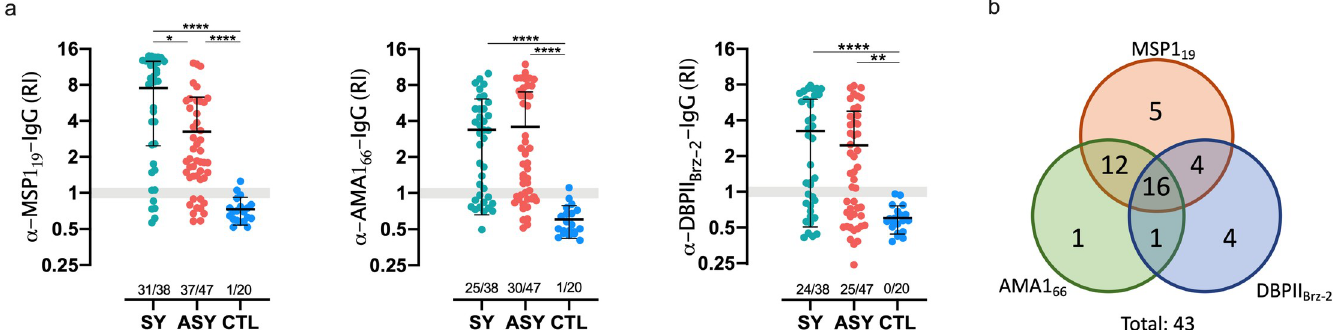
Fig 5. Asymptomatic individuals have higher levels of IgG against P . vivax antigens compared to healthy controls. a) Reactivity index for each individual by group for the three antigens. Each dot represents individual values of each analyte by group. Gray background represents the cut-off threshold. Data above the background is positive, and bellow, negative. Data upon the gray line is considered inconclusive. Y-axis is Log2 transformed to better show the distribution of negative individuals. Only significant differences were shown. �� p < 0.01. ���� p < 0.0001. Dunn’s test. b) Venn’s Diagram depicting the distribution of IgG positive ASY for the three antigens. RI–reactivity index. SY–symptomatic patients. ASY–Asymptomatic individuals. CTL—healthy